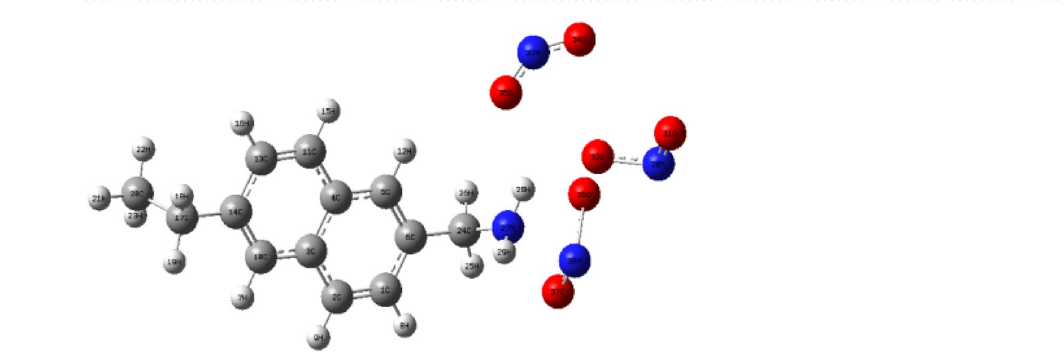
Figure 3. Adsorption equilibrium configuration of three NO 2 molecules on the coal surface side